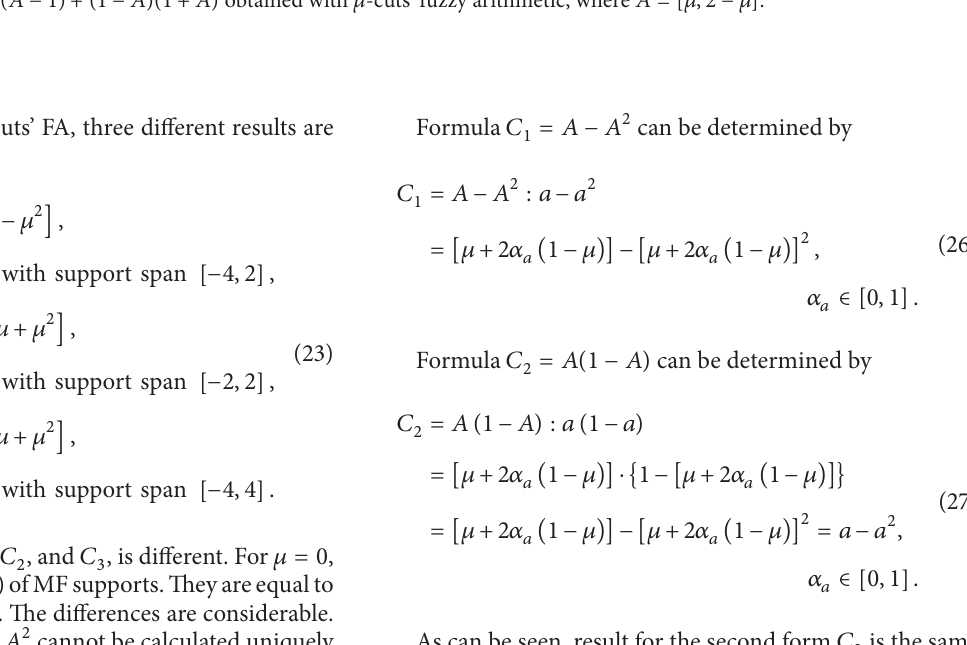
Figure 4: Three different membership functions of “results” of the fuzzy formula 𝐶 = 𝐴 − 𝐴 2 written in three equivalent forms 𝐶 1 = = 𝐴( 1 − 𝐴) , 𝐶 = (𝐴 − 1 ) + ( 1 − 𝐴)( 1 + 𝐴) obtained with 𝜇 -cuts’ fuzzy arithmetic, where 𝐴 = [𝜇, 2 − 𝜇] 𝐴 − 𝐴 2 , 𝐶 2 3